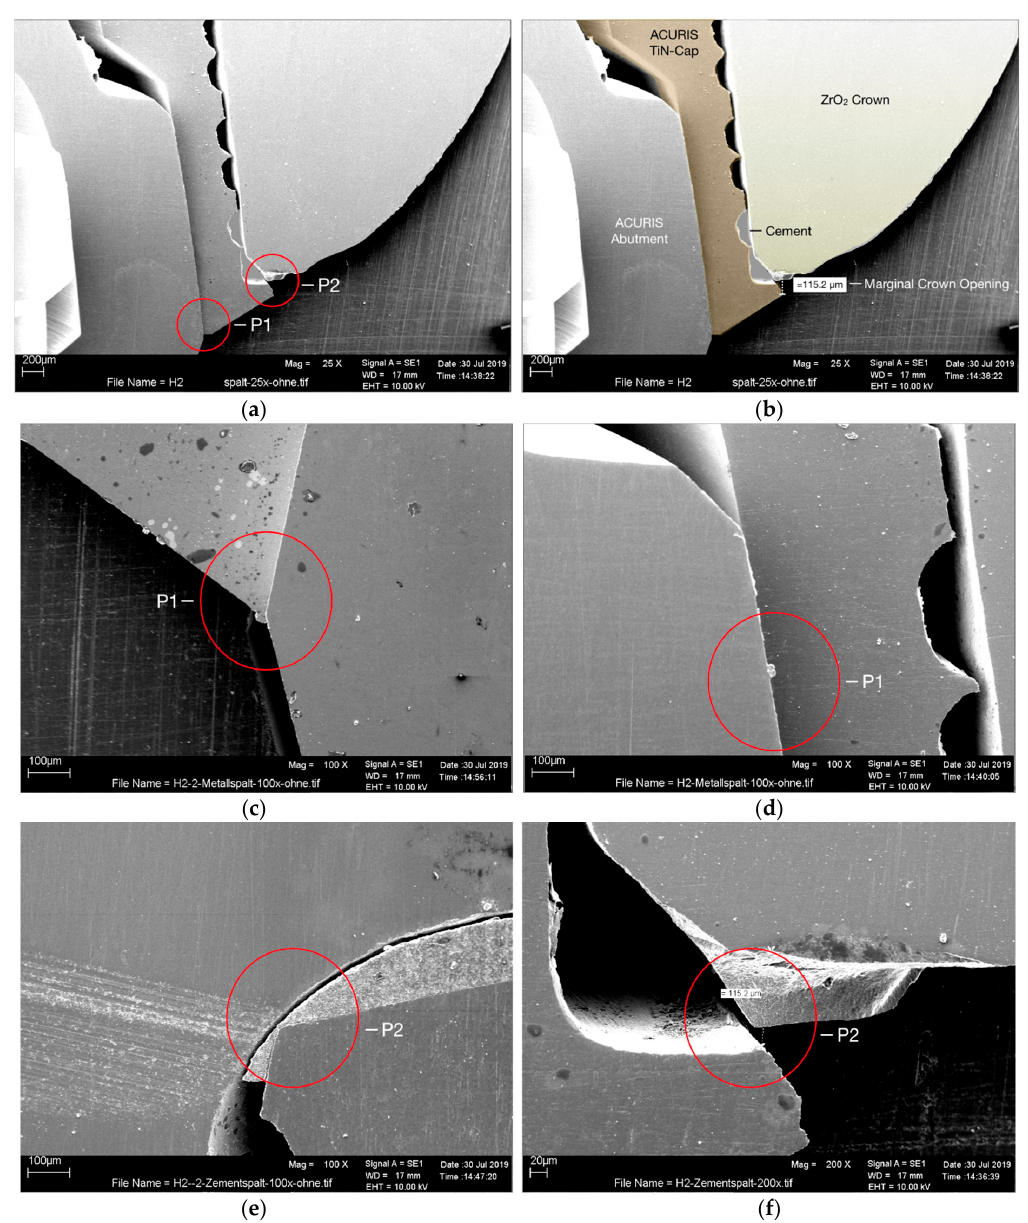
Figure 3. SEM images ( a – f ) of morse taper Acuris coupling (measuring points P1) and marginal opening of zirconia crown (measuring points P2) at different magnifications (25 × , 100 × and 200 × ). SEM images c and d (100 × ) display no measurable microgap at the cone-in-cone Acuris junction (P1). Pictures e and f identified a luting gap/marginal opening between the Acuris TiN-cap and the ceramic crown within the clinically acceptable range of approximately 115 µ m